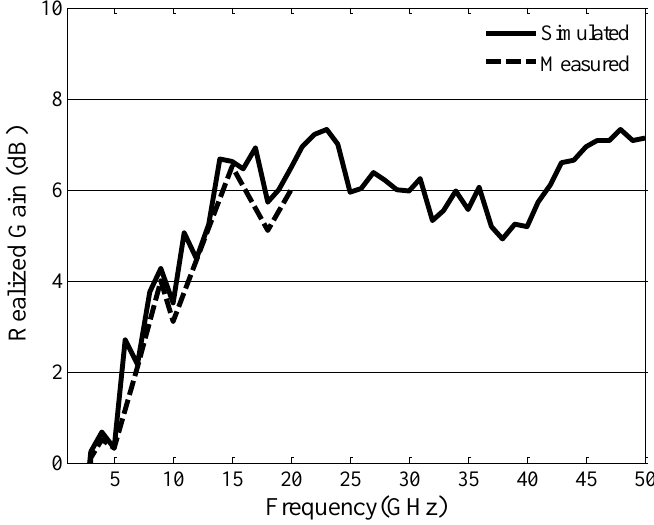
Figure 5. The simulated and measured return loss.